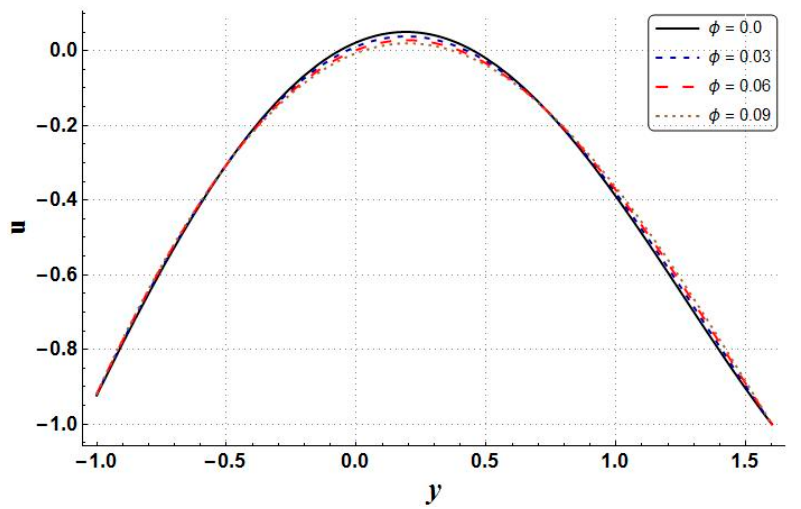
φ , x = 0, Gr = 2, α = π , 4 4 , where